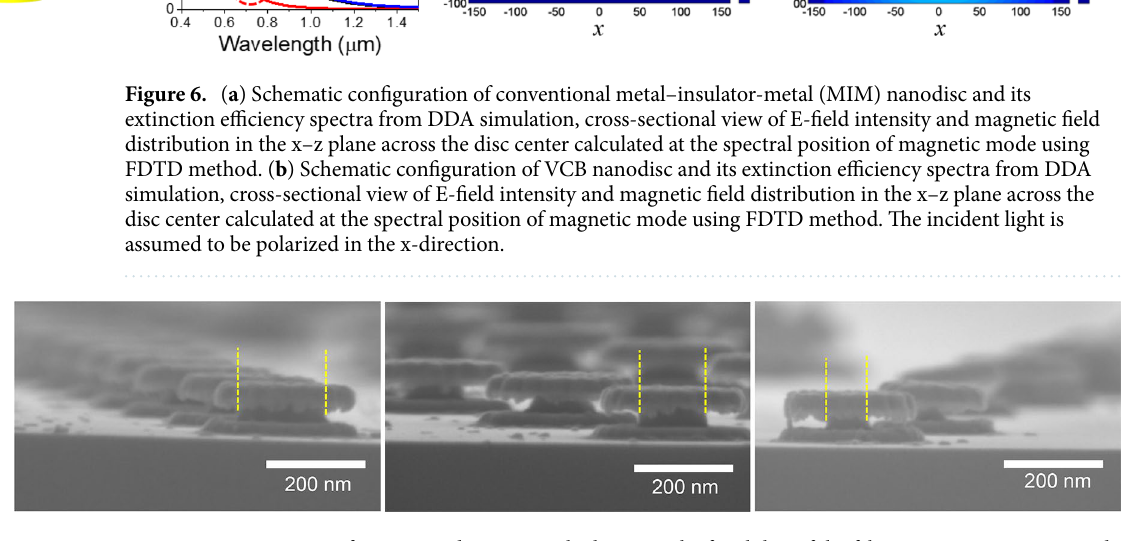
Figure 7. SEM images of VCB nanodiscs array which proves the feasibility of the fabrication process